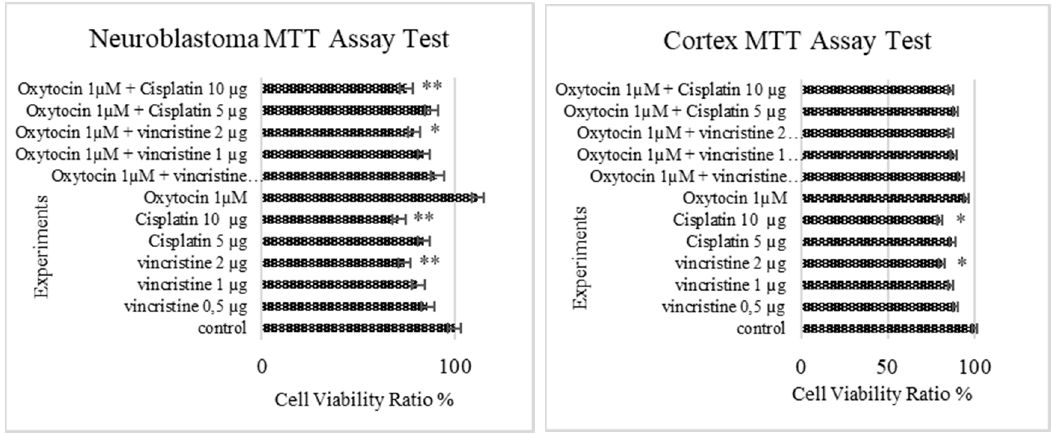
Figure 1. In vitro viability ratio of chemotherapy and oxytocin combination on primary cortex neurons and neuroblastoma cells ( n = 6/group) is shown. * Significant differences at p < 0.05 compared to control group; ** Significant differences at the p < 0.001 compared to control